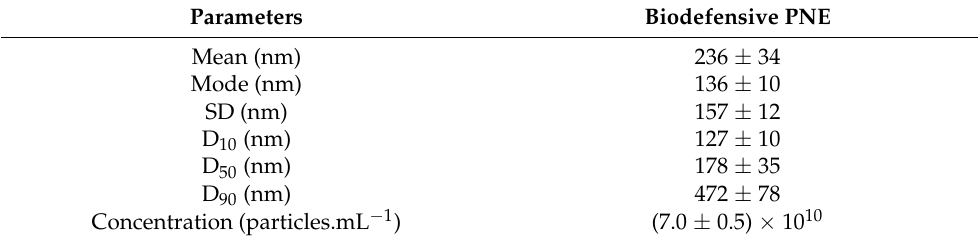
Table 1. Average particle size of the biodefensive PNE measured by